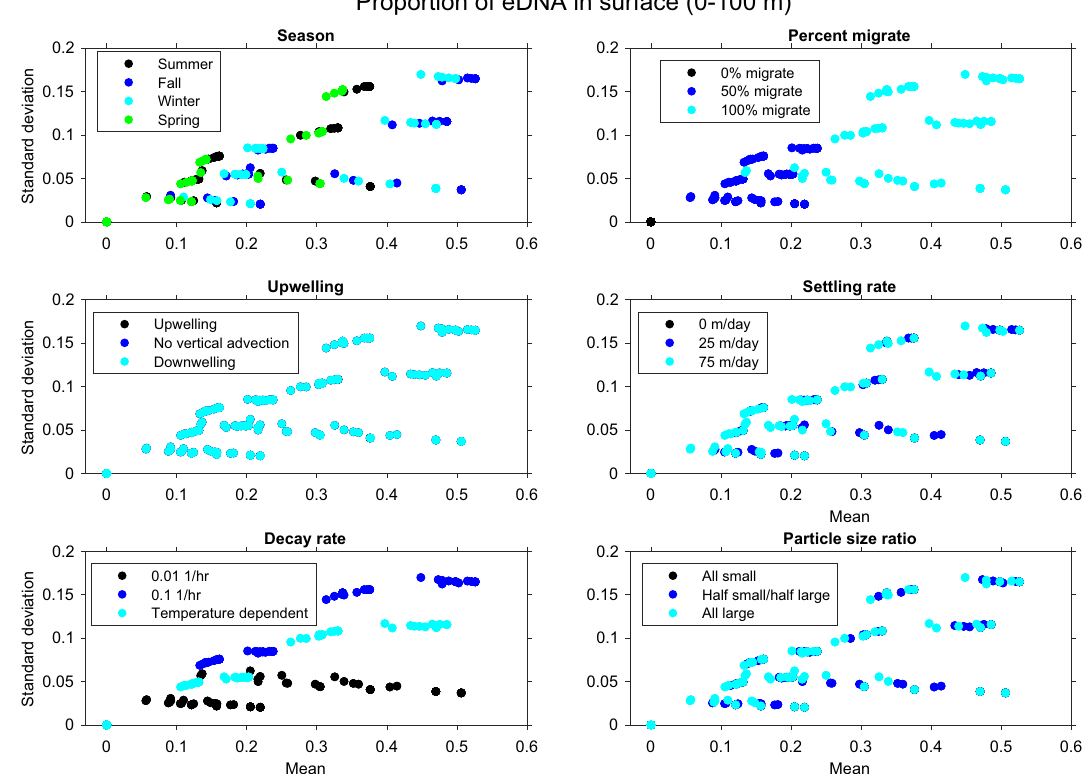
Figure 5. Standard deviation vs. mean proportion of eDNA found in the surface depth bin (0-100 m) for the sensitivity analysis of 972 simulations. All panels show the same data but colored by different parameters. Panels show the influences of seasons (summer, fall, winter, spring), percent of individuals that migrate (0, 50, 100%), 4 4 1 1 1 1 1 1 vertical advection ( 10 − ms − , 0 ms − , − 10 − ms − ), settling rate (0 mday − , 25 mday − , 75 mday − ), eDNA 1 1 decay rate (0.01 h − , a temperature dependent relationship, or 0.1 h − ,), and the ratio of small to large particles (all small, half small/half large, all large).